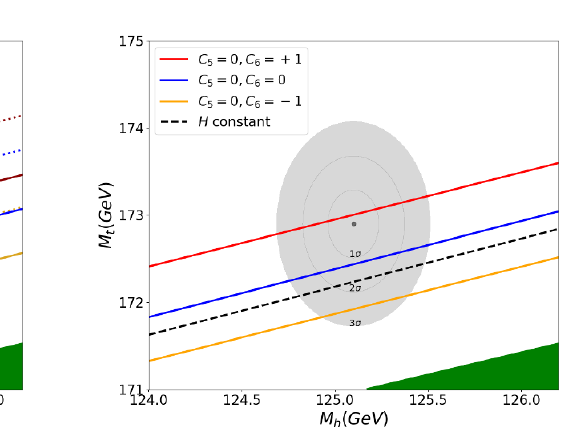
(a) E(cid:11)ect of the dimension-5 operator on (b) E(cid:11)ect of dimension-6 operator on quartic- Starobinsky-like models. like models for H = 10 12 GeV. Figure 8. Bounds on the top/Higgs masses from the energy scale of in(cid:13)ation for (cid:24) = (cid:0) 0 : 01, (cid:11) s = 0 : 1181 and T RH & 10 14 GeV(equivalent to demanding no Hubble patch in AdS at the end of in(cid:13)ation), for di(cid:11)erent setups listed in the legend. Any given scenario marks a line separating the excluded region in parameter space (above) from the allowed one (below). In green, the stability region where the quartic Higgs coupling stays positive up to the Planck scale. The dashed black line on the right plot stays for the benchmark analysis done assuming H = 10 12 GeV = const and f = 1.